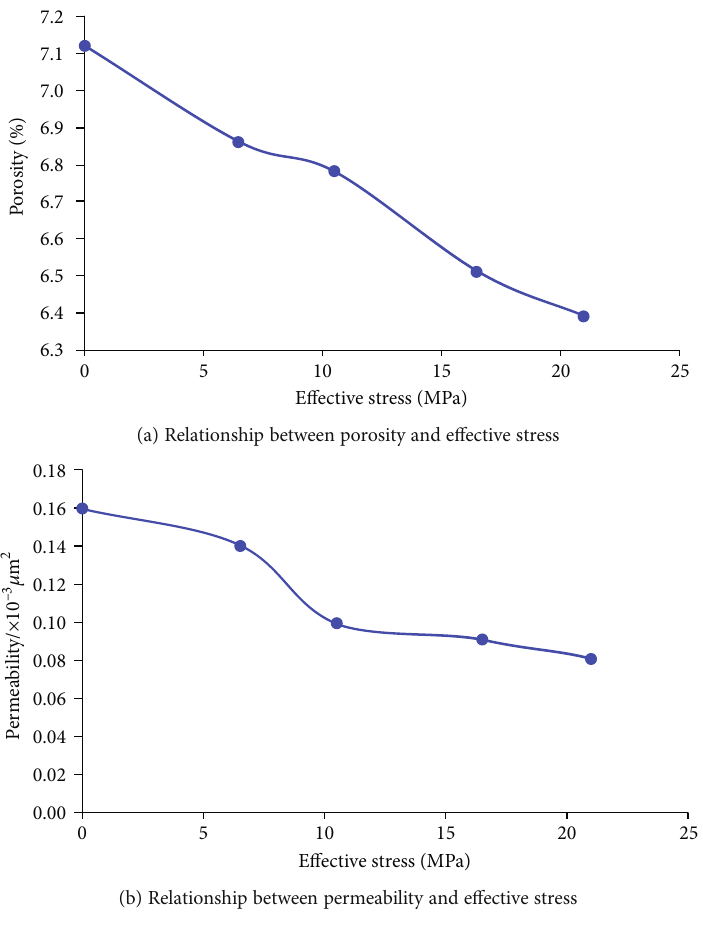
(b) Relationship between permeability and e ff ective stress Figure 4: Porosity and permeability changes with increasing e ff ective stress.